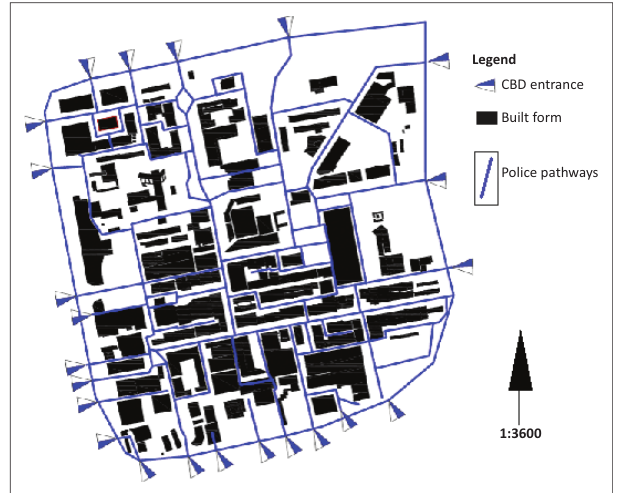
FIGURE 8: Police pathways. CBD, central business